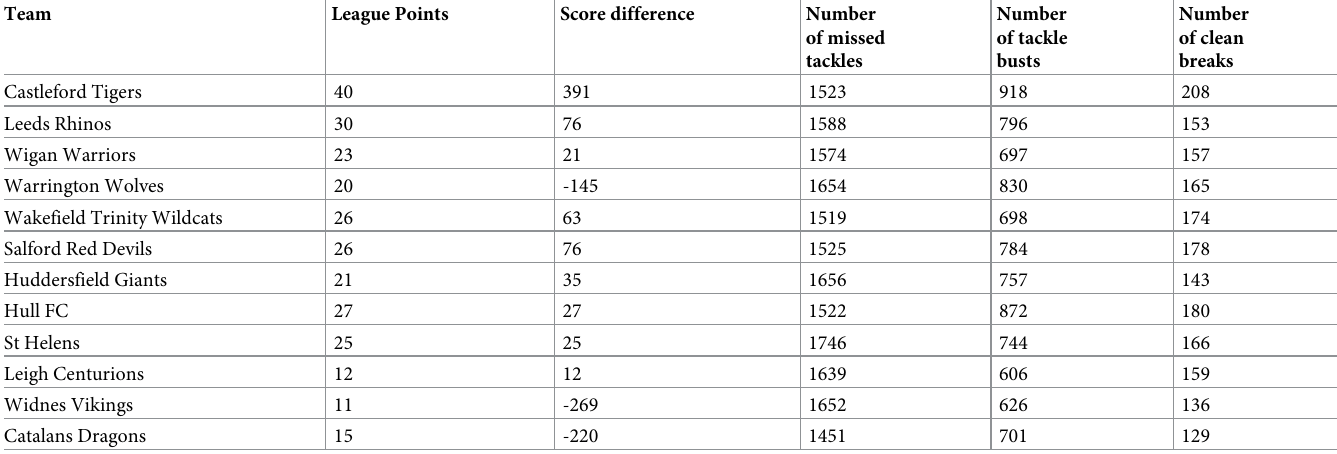
Table 1. League outcome and match performance data for the teams in the European Super League (season